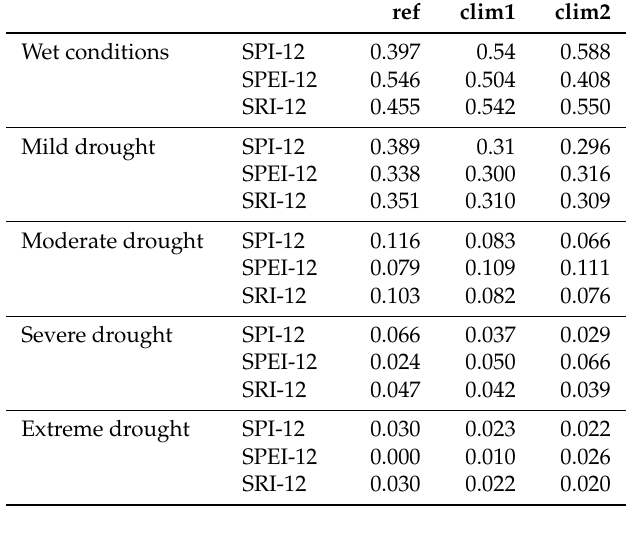
Table 8. A comparison of the median probability of recurrence of five types of dryness conditions estimated using the SPI-12, SPEI-12 and SRI-12 in the reference (Ref) and two future periods (clim1 and clim2).